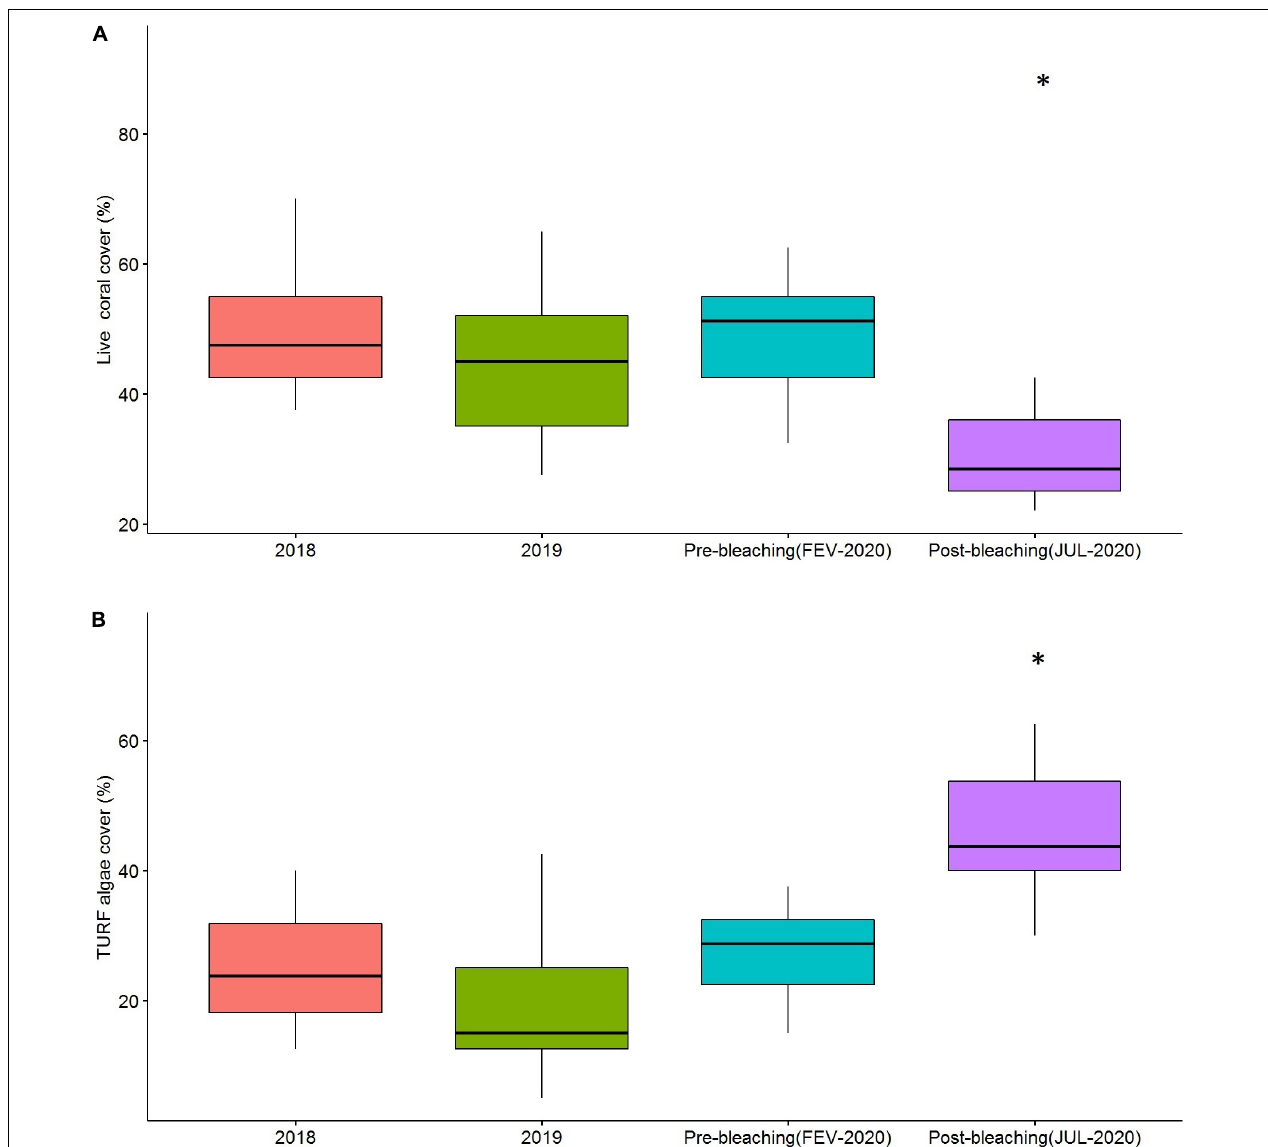
FIGURE 5 | Live coral cover (%) (A) and algal turf cover (B) on marine protected area (MPA) Costa dos Corais with temporal data and pre/post bleaching period. *Means significant differences.